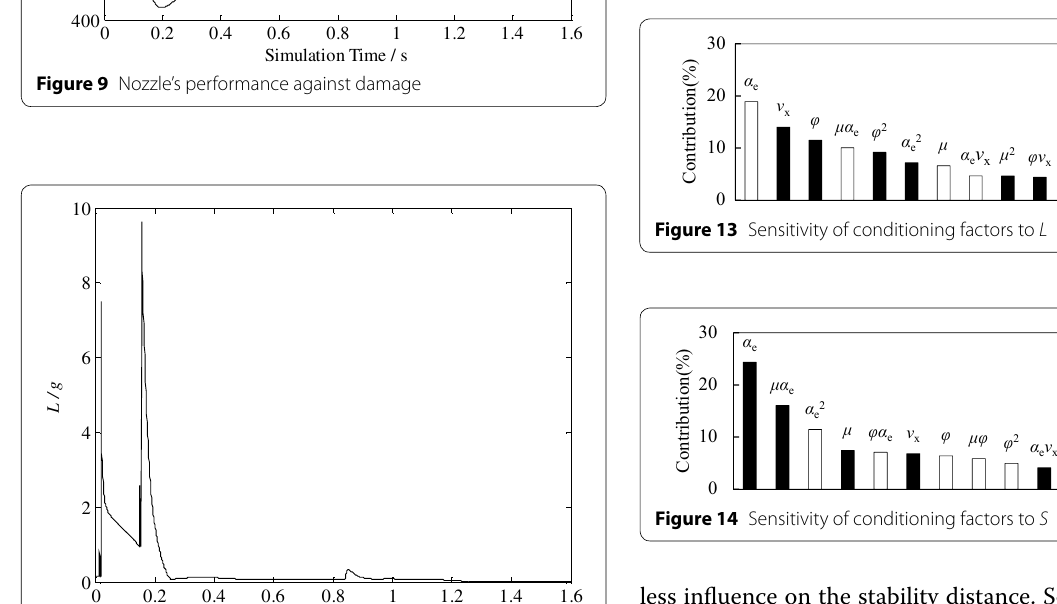
Figure 12 Sensitivity of conditioning factors to U